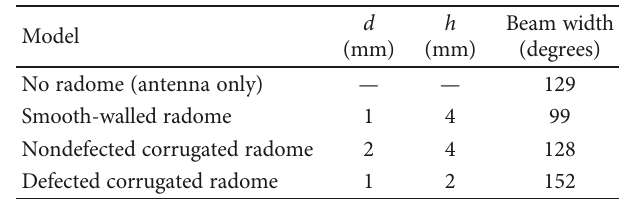
Figure 17: Photographs of the fabricated radomes. Table 6: Radome thickness, height, and measured beam